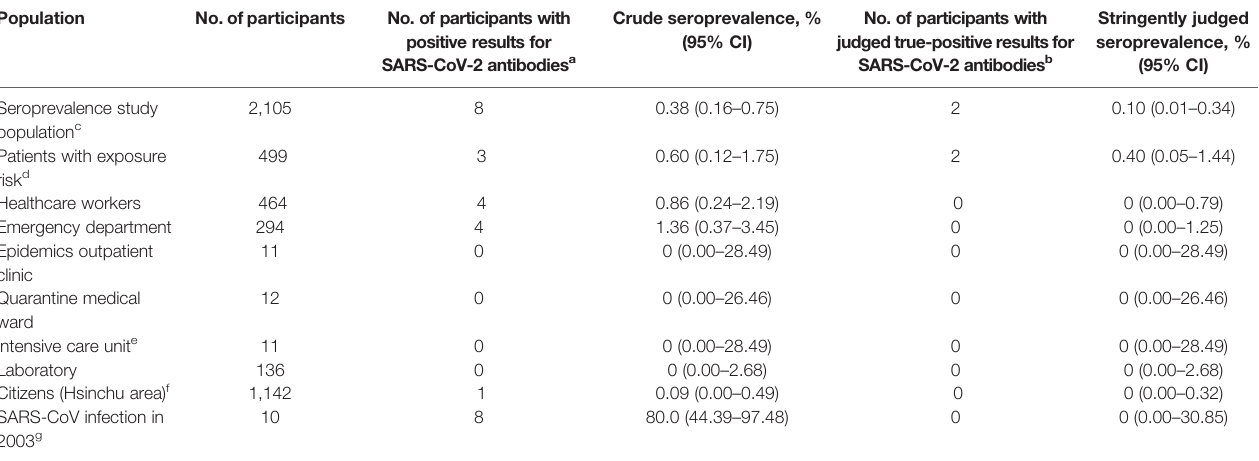
TABLE 4 | Summary of sources of participants and corresponding seroprevalence for coronavirus disease 2019 using Roche Elecsys ® Anti − SARS − CoV − 2 test and Abbott SARS-CoV-2 IgG assay. Population